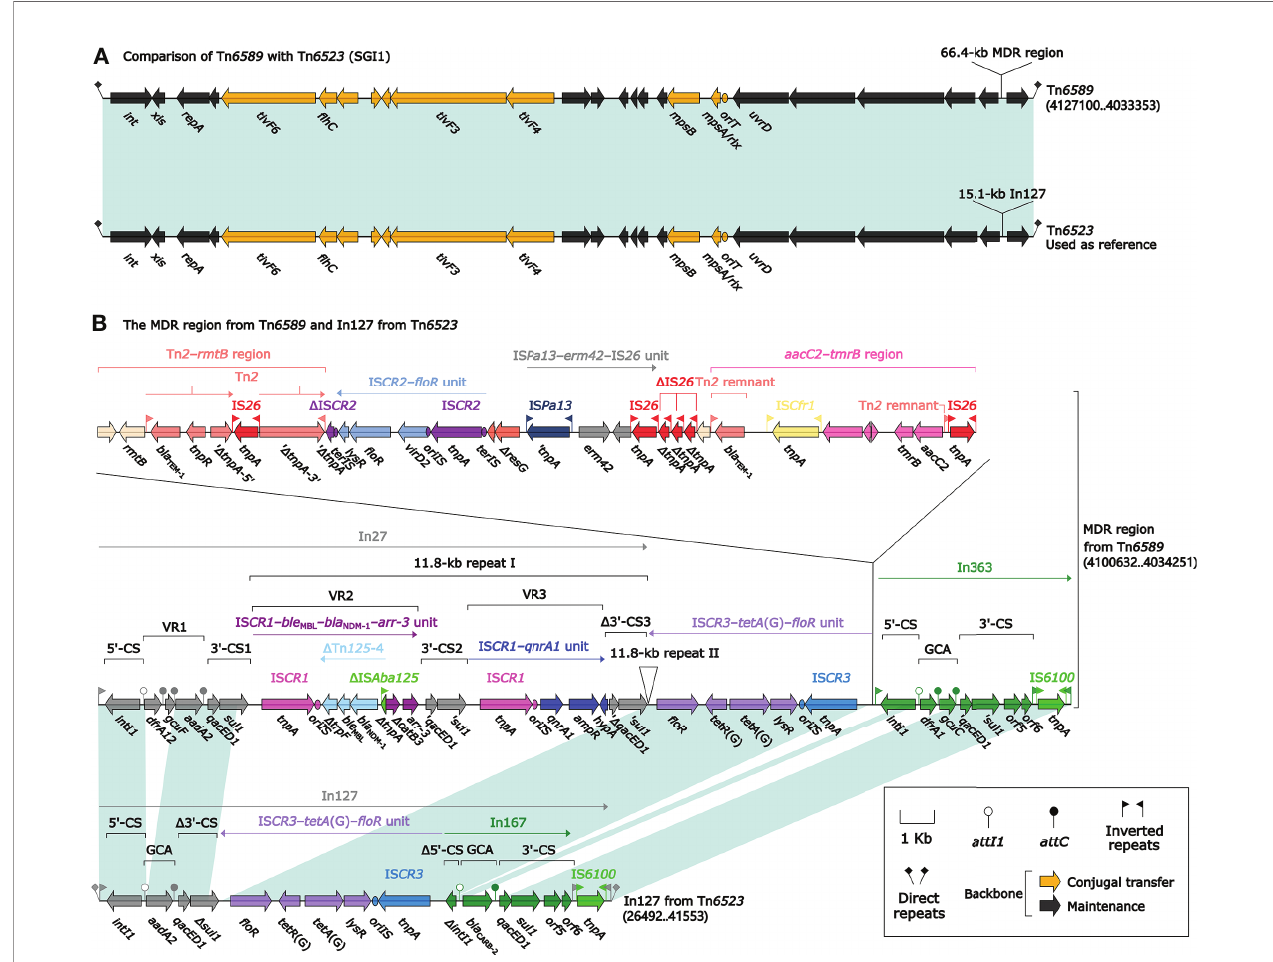
FIGURE 3 | Shown are two Tn 6523 -related transposons (A) , and MDR region from Tn 6589 and In127 from Tn 6523 (B) . Genes are denoted by arrows. Genes, mobile elements, and other features are colored based on their functional classi fi cation. Shading denotes regions of homology (nucleotide identity ≥ 95%). Numbers in brackets indicate nucleotide positions within Tn 6523 (Boyd et al., 2000) and the chromosome of strain 1701092. The accession number of Tn 6523 used as reference is